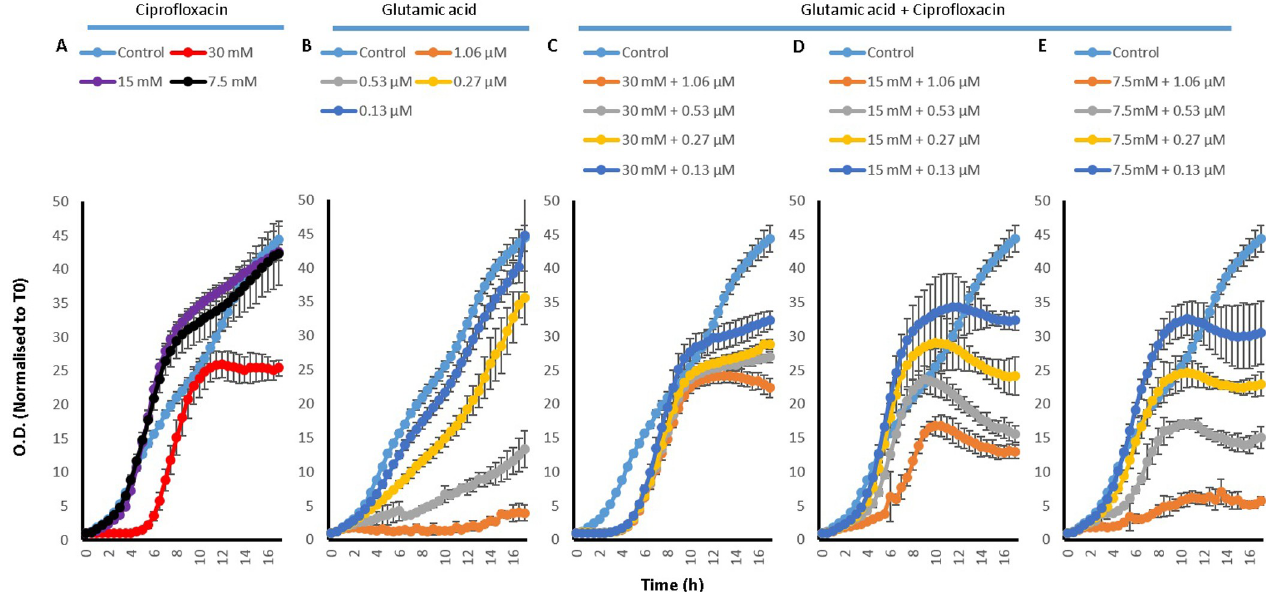
Fig 8. P . aeruginosa growth curves with A) 30, 15 and 7.5 mM L-Glu amino acid on its own, B) with 1.06, 0.53, 0.27 and 0.13 μ M Cip on its own, C) 30 mM L-Glu combined with 1.06, 0.53, 0.27 and 0.13 μ M Cip, D) 15 mM L-Glu combined with 1.06, 0.53, 0.27 and 0.13 μ M Cip and E) 7.5 mM L-Glu combined with 1.06, 0.53, 0.27 and 0.13 μ M Cip; n = 3.